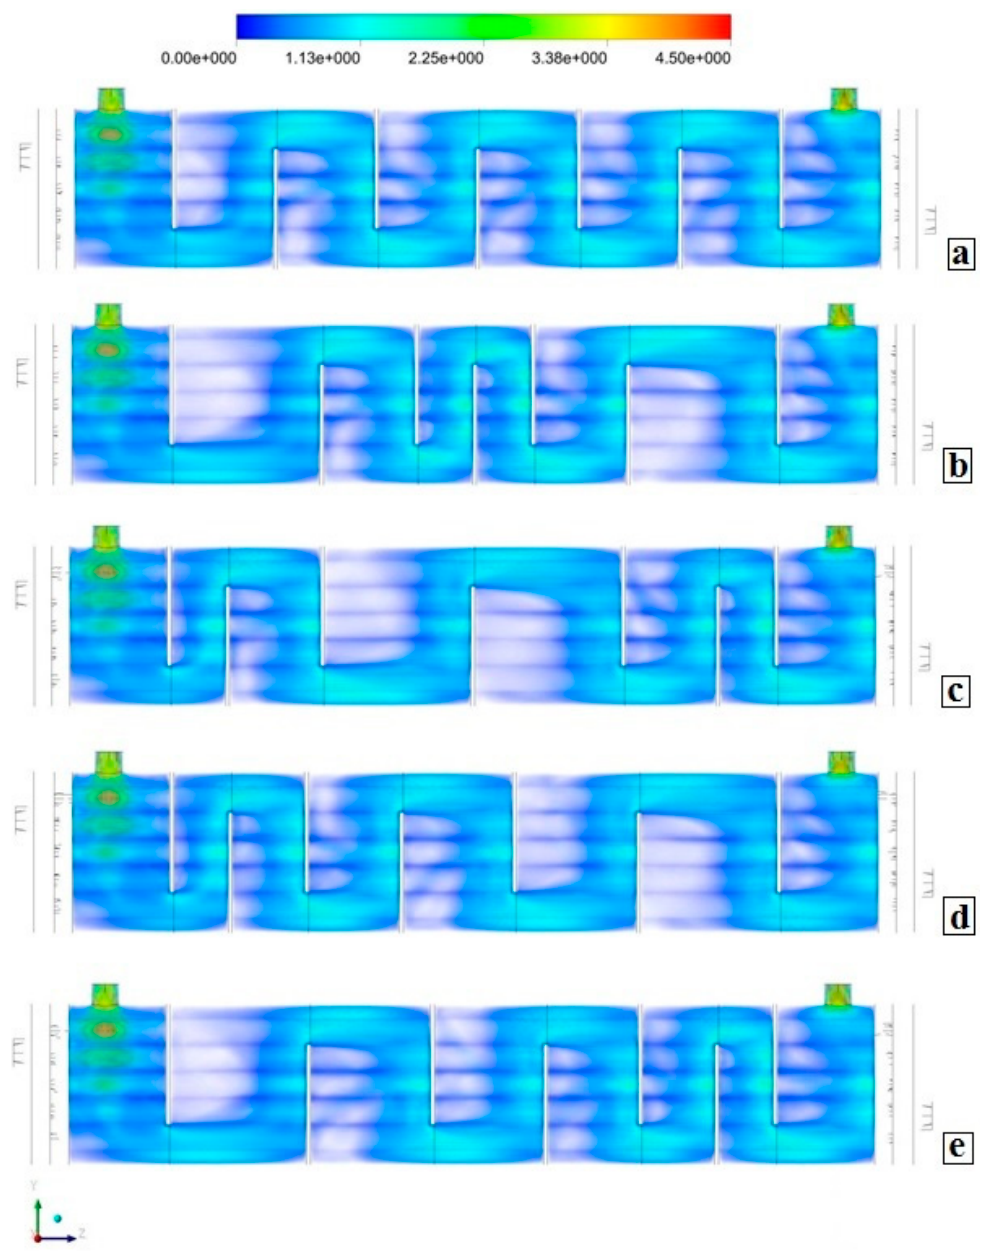
Figure 16. Prediction of velocity (m s -1 ) distribution of shell side flow ( a ) Case-I ( b ) Case-II ( c ) Case-III ( d ) Case-IV ( e ) Case-V.